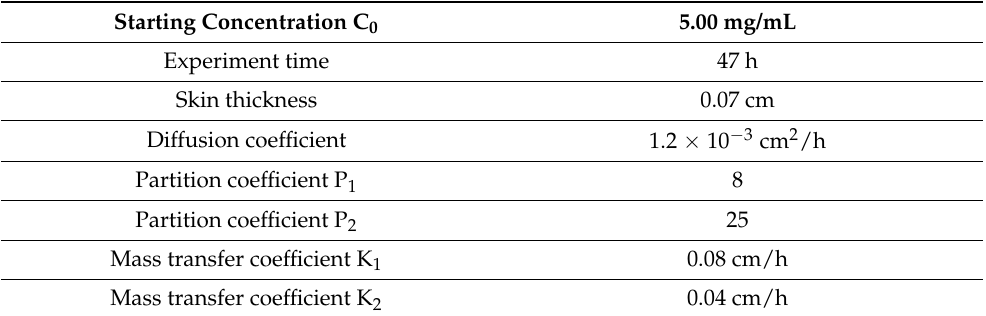
Table 2. Estimated parameter values for simulations of diclofenac at room